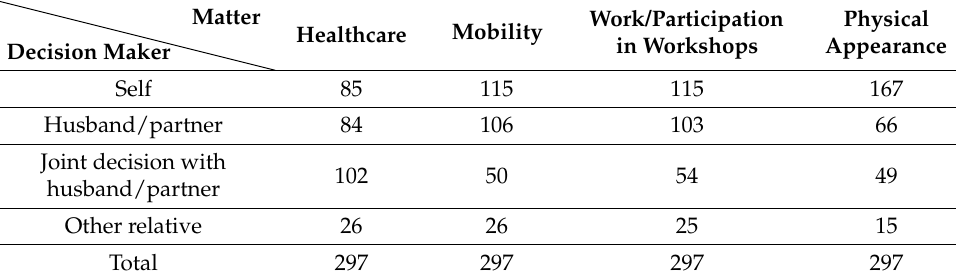
Table 2. Final decision maker in household on matters that concern the young women.